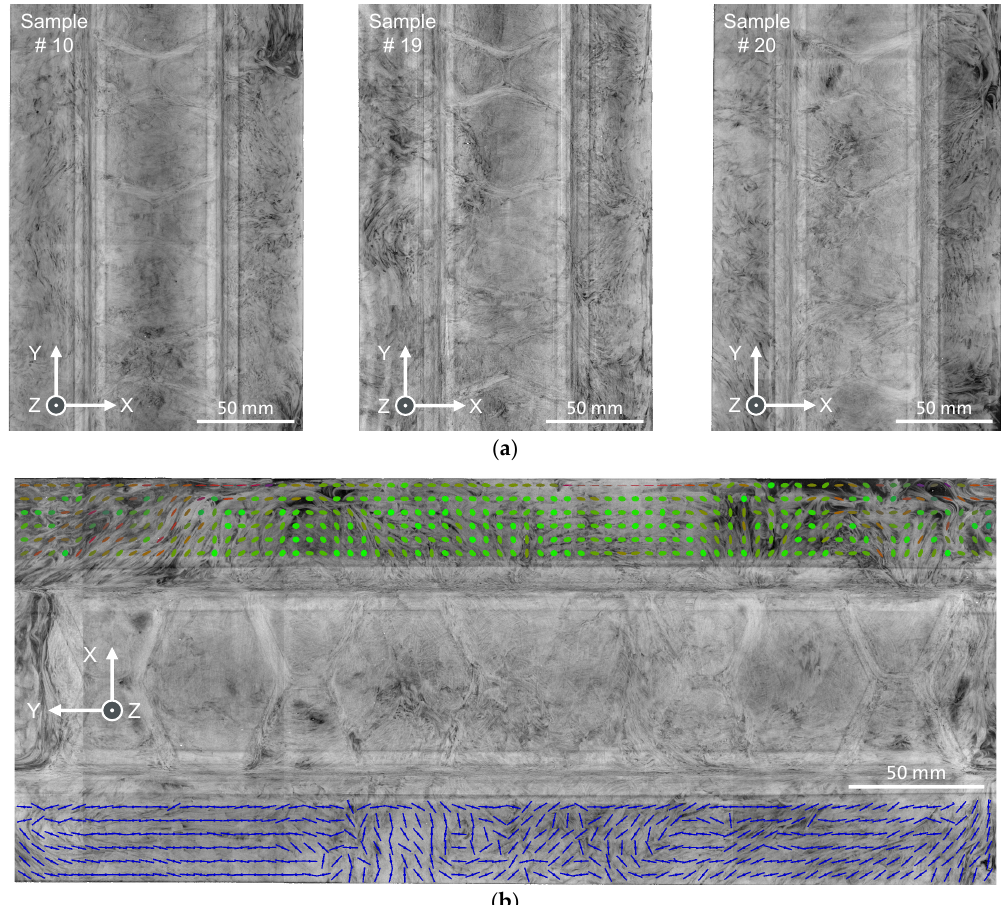
Figure 22. ( a ) CT images of the hat profile middle sections of all three scanned parts (top view; 1 mm of the each part surface is removed to see the inner strand bundle orientations); ( b ) fiber bundle orientations determined by VGSTUDIO MAX 3.3 on a 5 × 5 mm integration mesh in a wider section of sample #20 displayed as ellipsoids in the end brim and as vectors (1st eigenvector) in the plate brim.